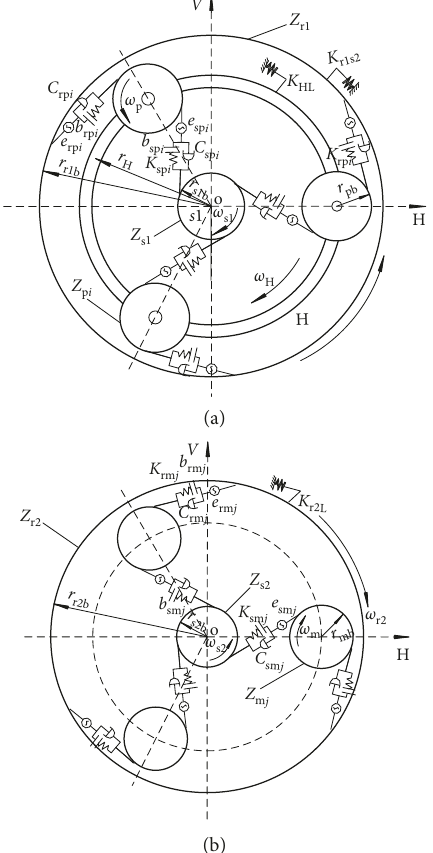
Figure 2: Dynamic model of encased differential planetary gear train. (a) Differential stage dynamic model. (b) Encased stage dynamic